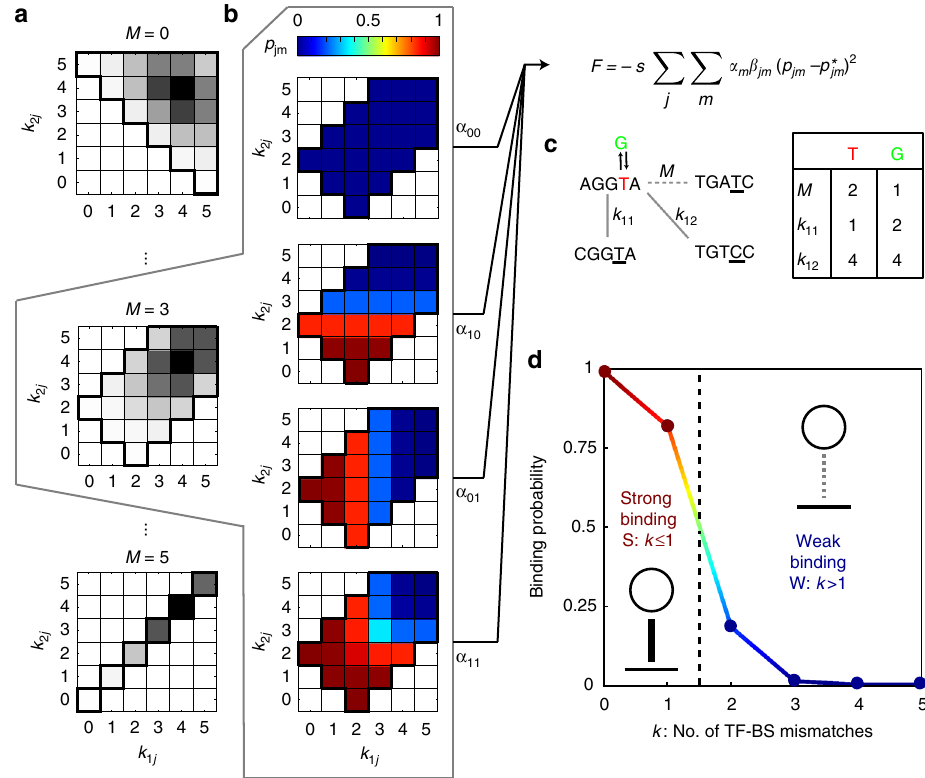
Fig. 2 Biophysical and evolutionary constraints shape the genotype – phenotype- fi tness map after TF duplication. a Match, M , between transcription factor consensus sequences (here, of length L = 5), constrains the possible mismatch values, k 1 j , k 2 j , between the gene ’ s binding site and either TF. For example, when the two TFs are identical ( M = L = 5, bottom left), they must have equal mismatches with all genes ( k 1 j = k 2 j ). Some combinations of mismatches are impossible given M ( white ), while others are realized by different numbers of genotypes ( grayscale ). b Expression level (color) for a regulated gene given all mismatch combinations, k 1 j , k 2 j , at M = 3. Impossible mismatch combinations are colored white. Each of the four panels shows expression levels in four possible environments, m = 00, 10, 01, 11. Fitness F depends on the structure of mismatches a , the biophysics of binding b , and the frequencies of different environments, α m . Here we choose α so that the marginal probability of each input signal f 1,2 is always f 1 = f 2 = 1 but the correlation can be varied, and 2 when it is induced when it should not. The general case when f 1 ≠ f 2 ≠ 0.5 assign weight β jm = 1 whenever the gene should be induced but is not, and β jm = 1 2 is analyzed in Supplementary Note 2. c A single point mutation, e.g., a change in one TF ’ s binding speci fi city from ‘ T ’ to ‘ G ’ , can simultaneously affect the match, M , and either increase, decrease, or leave intact the mismatches, k 11 and k 12 , that determine fi tness. d TF – BS interactions with mismatch k that is low enough to ensure a high binding probability ( p > 1/2) are assigned to a “ strong binding ” phenotype ( solid link ); conversely, p < 1/2 is a ‘ weak binding